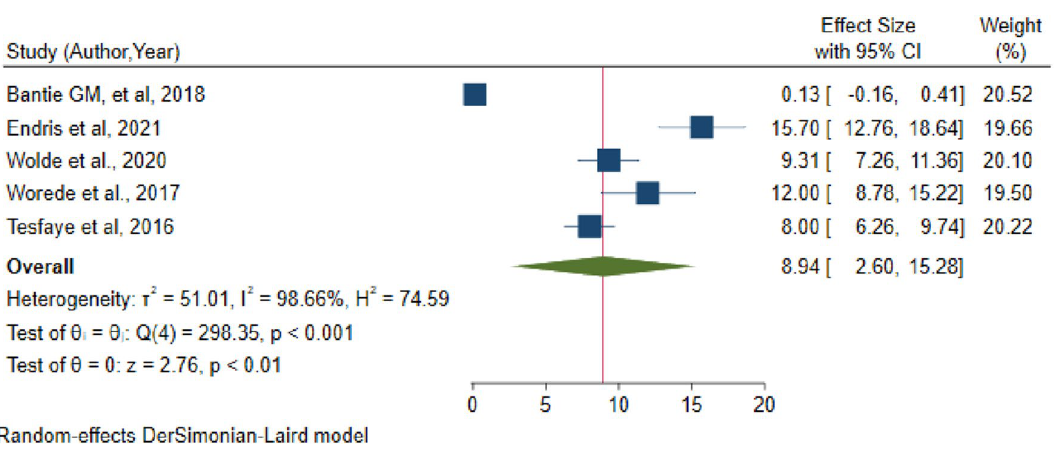
Figure 3. Forest plot of pooled prevalence of impaired fasting glucose in Ethiopia,